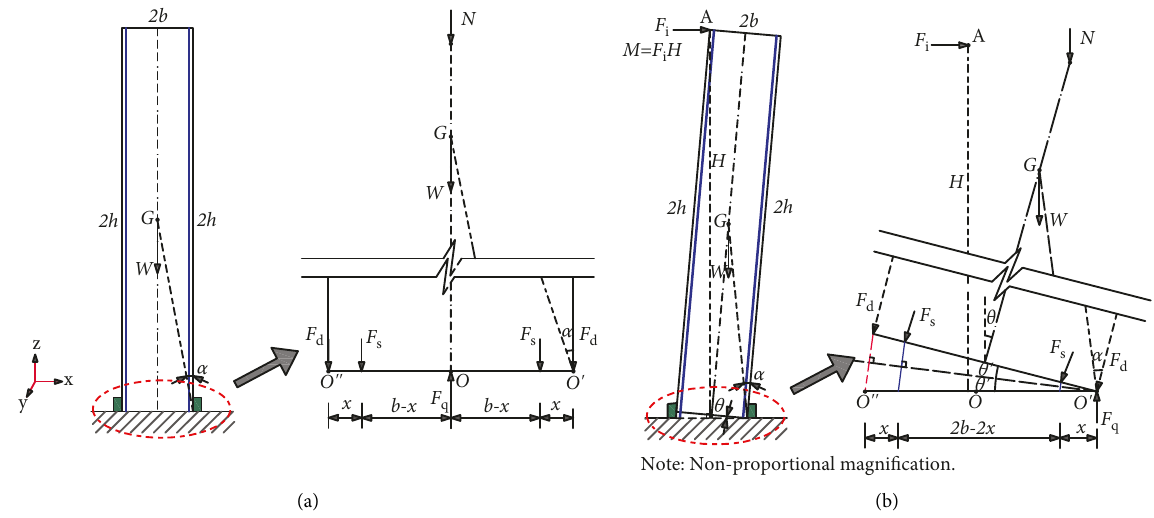
Figure 4: The schematics of the RED-HRC forces and deformations. (a) In the initial state. (b) In the rocking